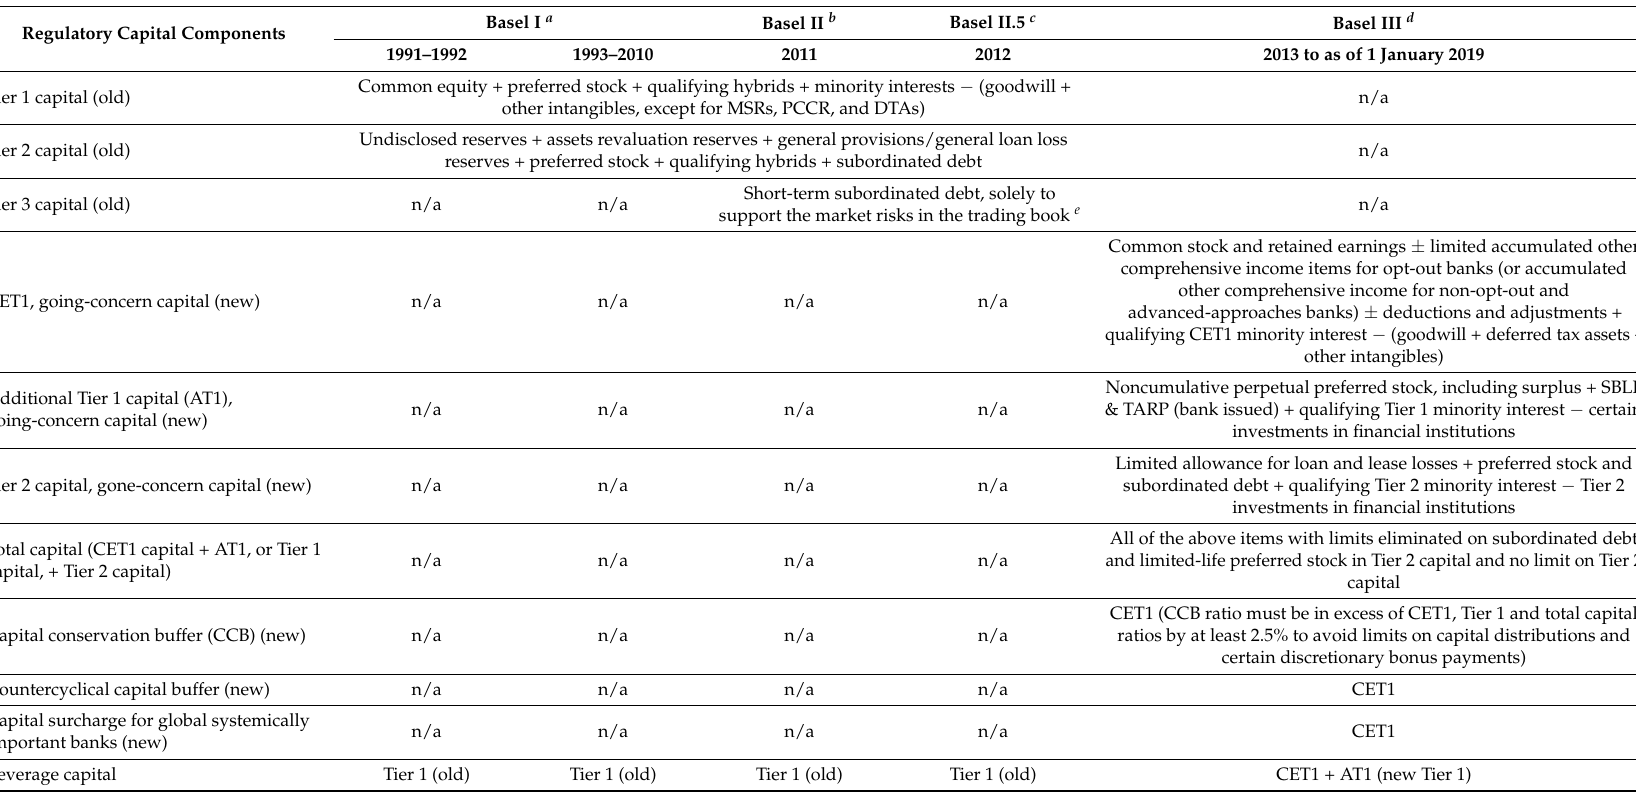
Table 4. A Timeline of US Regulatory Capital